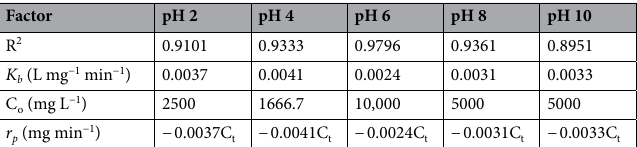
Table 2. CF kinetics at 0.2 g PNSC L −1 and 303 K at α = 1.